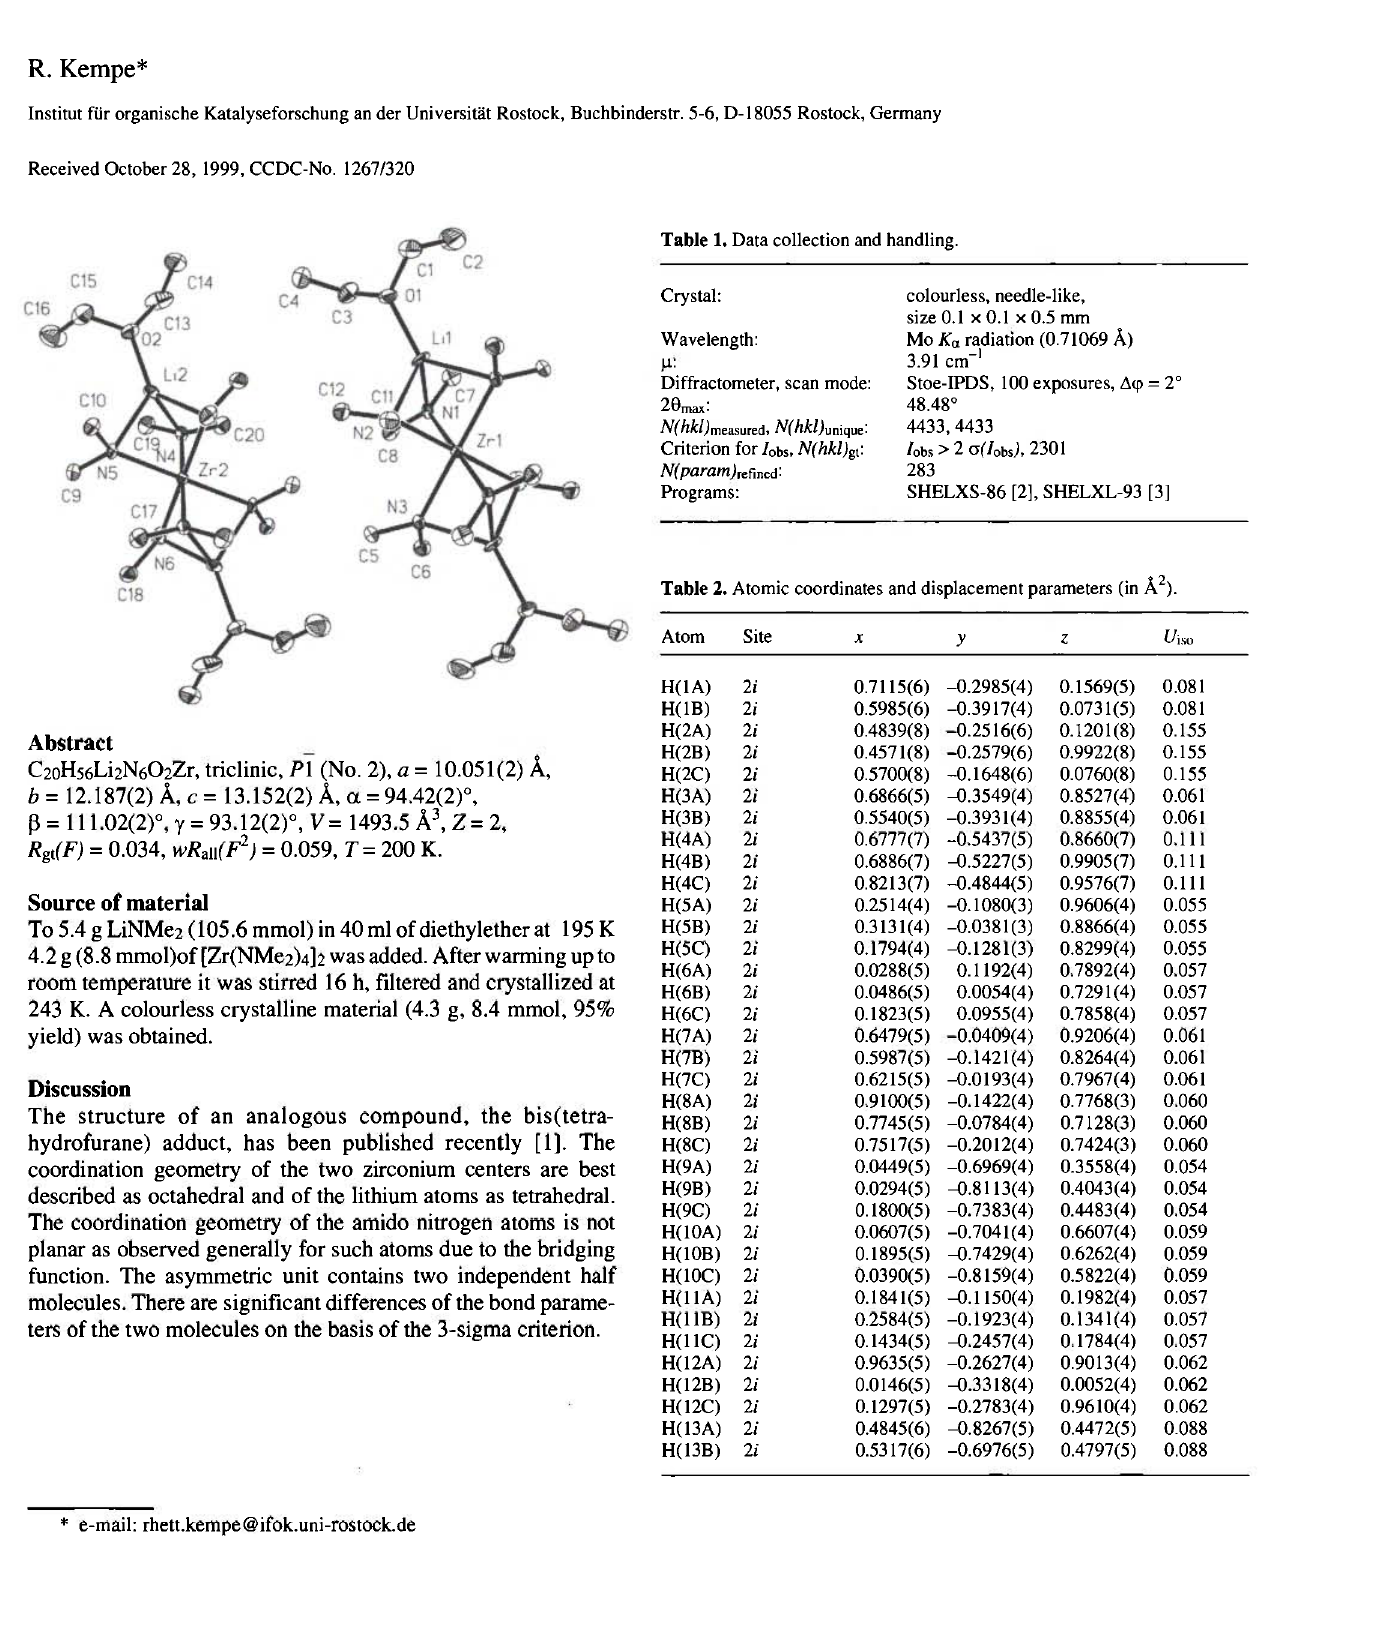
Table 1. Data collection and handling.